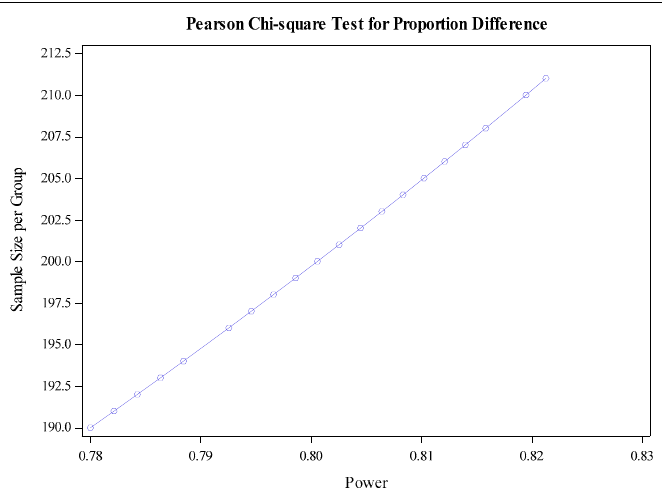
Figure A1. Power procedure of the futility analysis. Table A2. The SEQDESIGN Procedure.